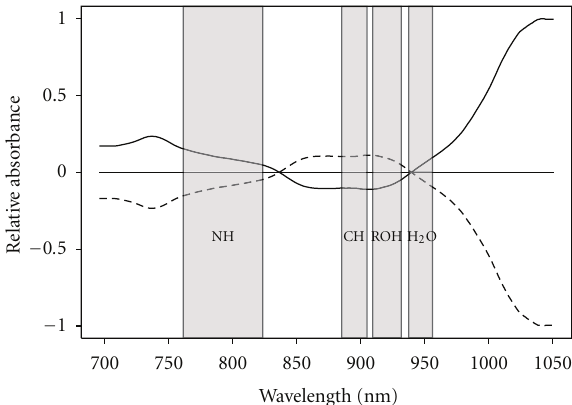
Figure 3: Normalized spectral absorbance for term and preterm groups. A solid line represents the term group ( ≥ 37 weeks), and the dashed line represents the pre-term group ( ≤ 35 weeks). This region of the spectrum consists of the 2nd and 3rd overtone absorption from CH, NH, and OH functional groups. Di ff ering concentrations of proteins, fats, and carbohydrates in the matrix lead to increased or decreased absorbance in the spectral region corresponding to the functional groups. The result is essentially a metabolome fingerprint for preterm and term births using 2nd trimester amniotic fluid.